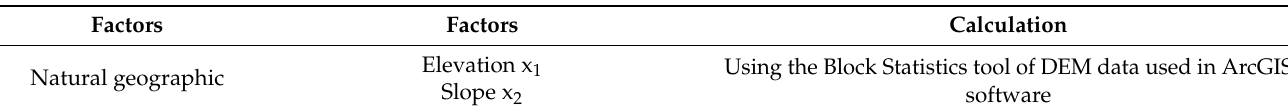
Table 4. The driving factors of homestead